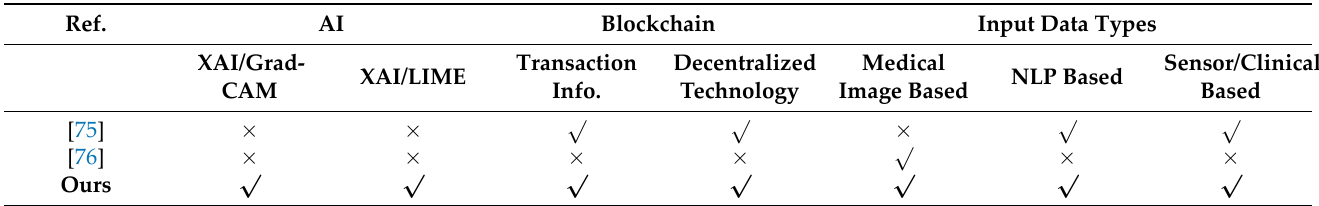
Table 2. Comparison of our architecture with other studies in the healthcare metaverse.